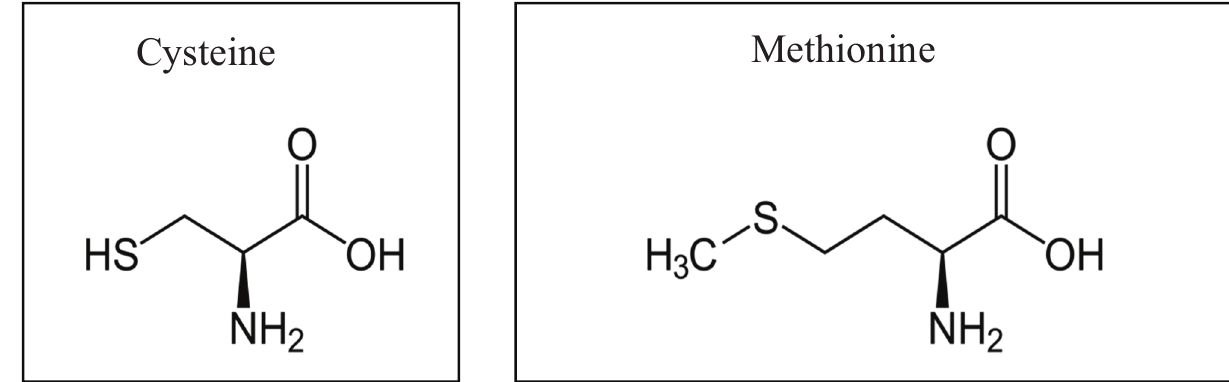
Figure 2. Structure of the sulfur containing amino acids cysteine and